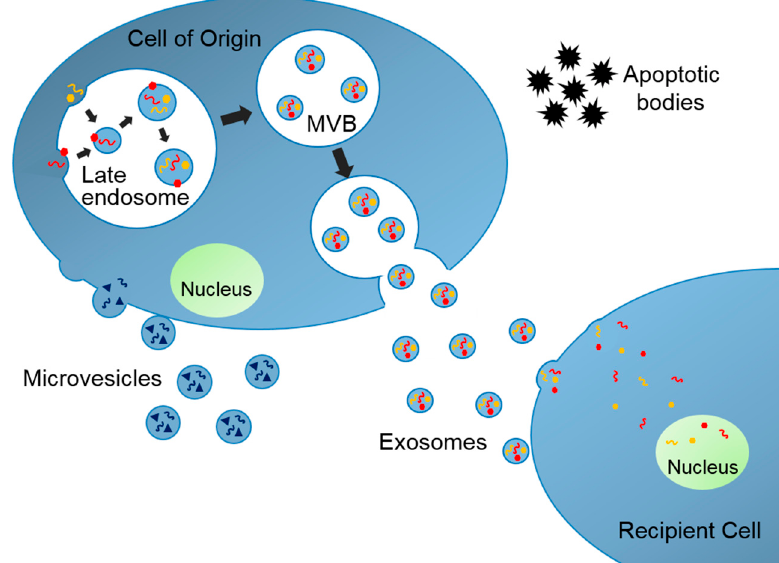
Figure 1. Biogenesis of Extracellular Vesicles. Exosomes are assembled within multivesicular bodies (MVBs) where specific exosomal cargos are sorted into exosomes. Microvesicles are generated from plasma membrane budding. Apoptotic bodies are aggregates of plasma membrane bleb. These vesicles travel to neighboring and distant organs and change the cellular function at the recipient tissues.